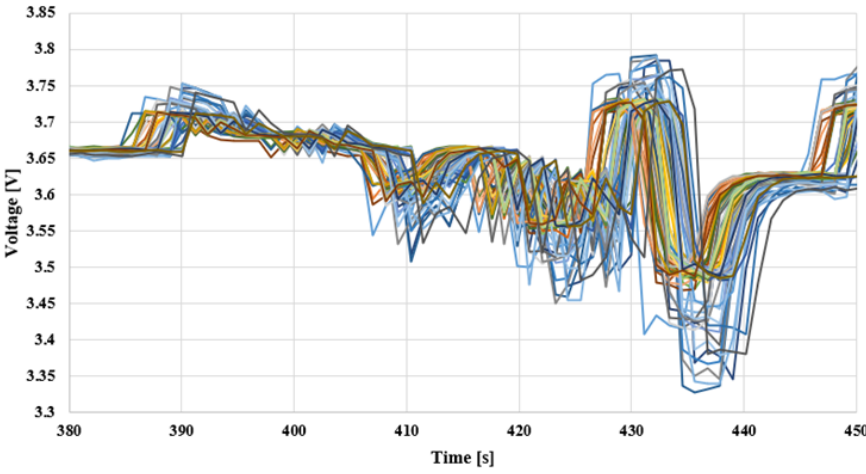
Figure 7. Data slippage analysis in Dynamic test 2 (the different color lines indicate the 88 battery cells).